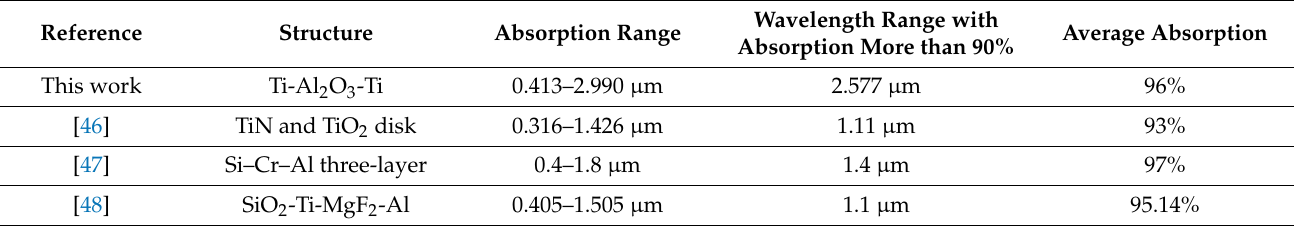
Figure 2. ( a ) the reflection (R), transmission (T) and absorption spectra of the solar absorber designed for normal incidence; ( b ) absorption effect under AM1.5 spectrum. Table 1. Absorption range of different structures with an absorption rate of more than